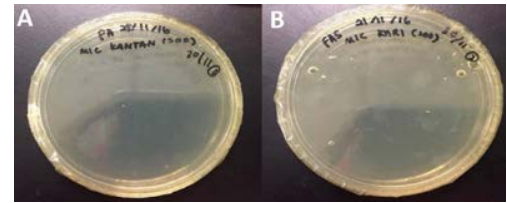
Fig. 2. The SDA plates that do not contain any C. albicans colony which is at 400mg/mL and 200 mg/ML for E. elatior (A) and M. koenigii (B) respectively were determined as the MFC of the plant Table 3. The presence of different phytochemicals in E. elatior and M. koenigii ectracts extracted using 80% methanol and 95% ethanol Plants Crude extract Flavonoid Alkaloid Tannins Glycosides Saponins Etlingera elatior Jack. 80% Methanol - + - + + 95% Ethanol + + + - - Murraya koenigii Spreng. 80% Methanol - + - + + 95% Ethanol + - + - + Table 4. MIC and MFC of both plant extracts were determined and compared. Plant Extract Concen. MIC MFC (mg/mL) (mg/mL) (mg/mL) Etlingera elatior Jack 95% ethanol 400 200 400 Murraya koenigii Spreng 95% ethanol 400 200 200 Table 5. FIC of the combined plant extracts when tested against C. albicans FIC Combined extracts of E. elatior (400mg/mL) and M. koenigii (400mg/mL) 1.0